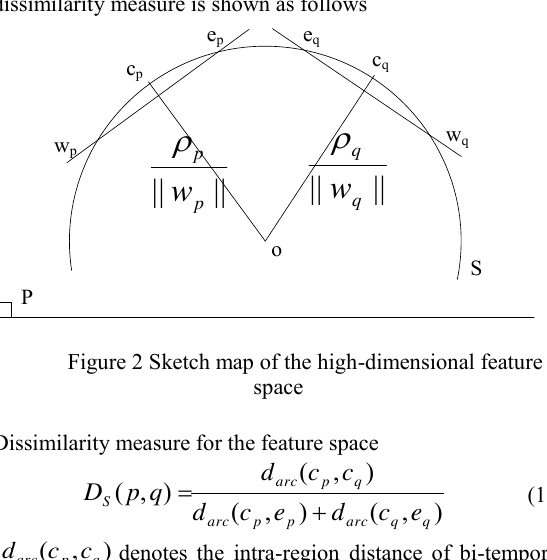
Figure 3. The steps of change detection method of